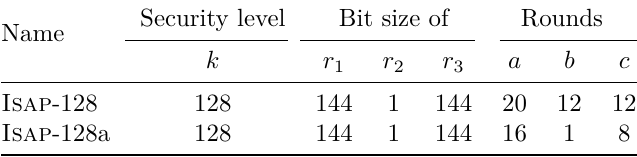
Table 1: Recommended parameter configurations for Isap .